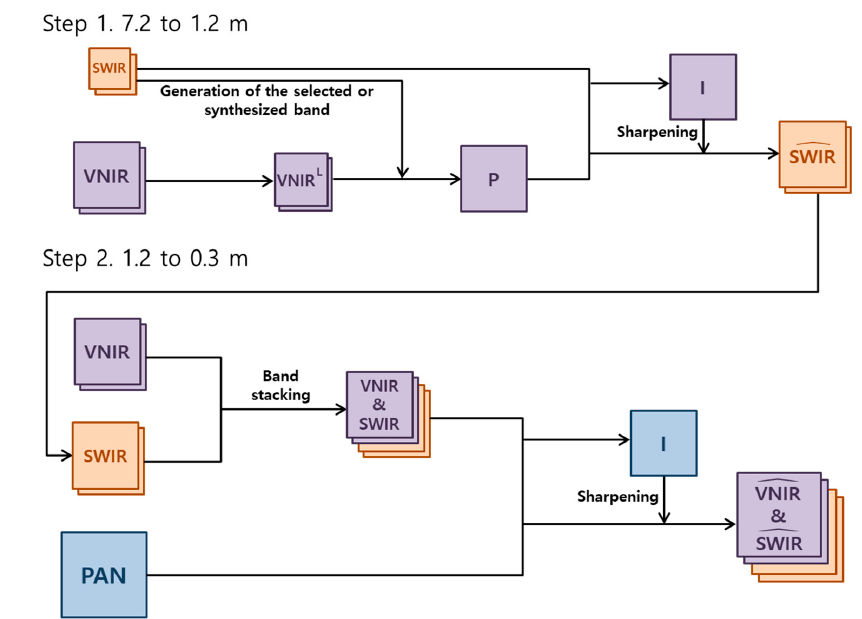
Figure 2. Workflow of the proposed Worldview-3 satellite image pansharpening technique.